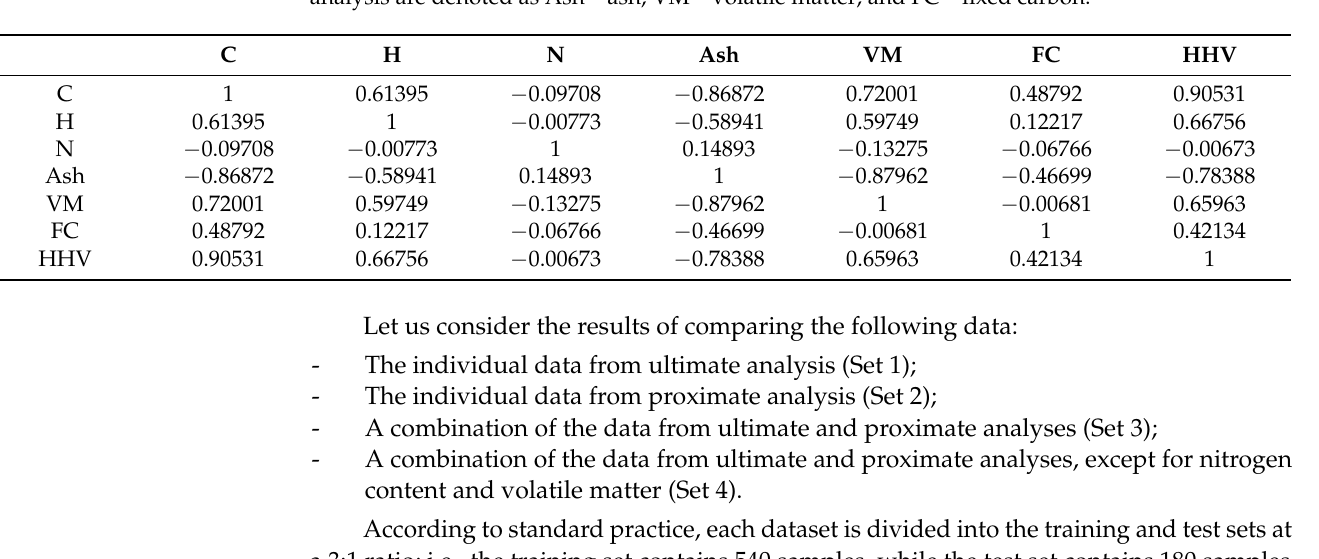
where x.mean is the mean value in the sample and x.std is the standard deviation of the mean value in the